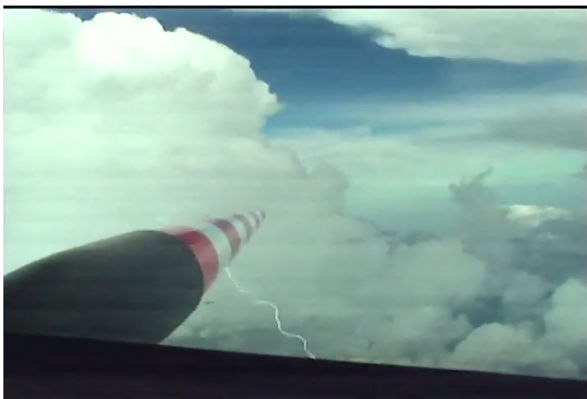
Figure 6. Image taken from the HALO cockpit just before the air- craft penetration of a convective cloud with lightning activity dur- ing flight AC07. In this case, the cloud pass height was 9022m (temperature ∼− 25 ◦ C) and the maximum CWC measured was 0.55gm − 3 .